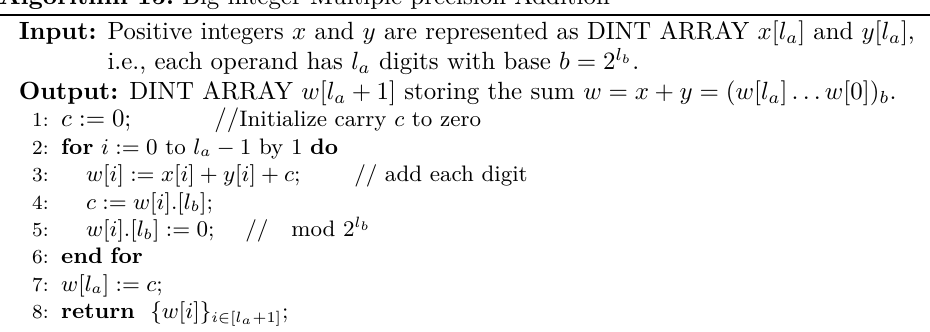
Algorithm 15: Big-integer Multiple-precision Addition